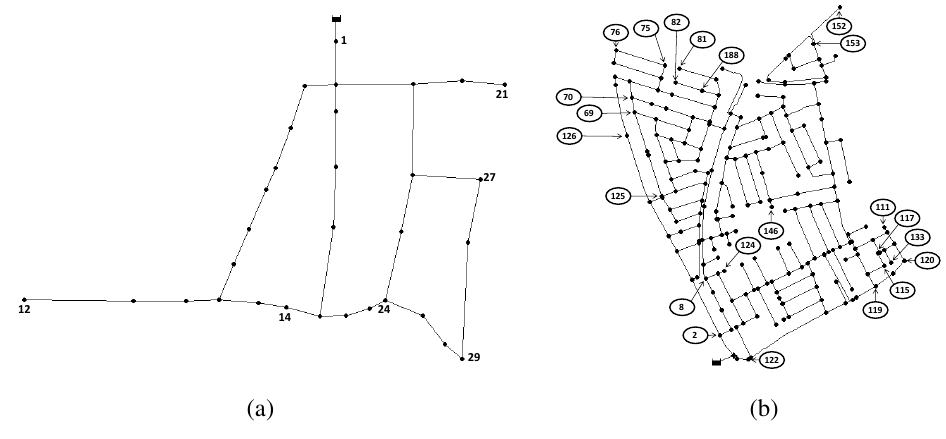
Figure 1. The Hanoi ( a ) and Limassol ( b ) water distribution networks (WDNs) used as benchmarks to evaluate the sensor placement method.